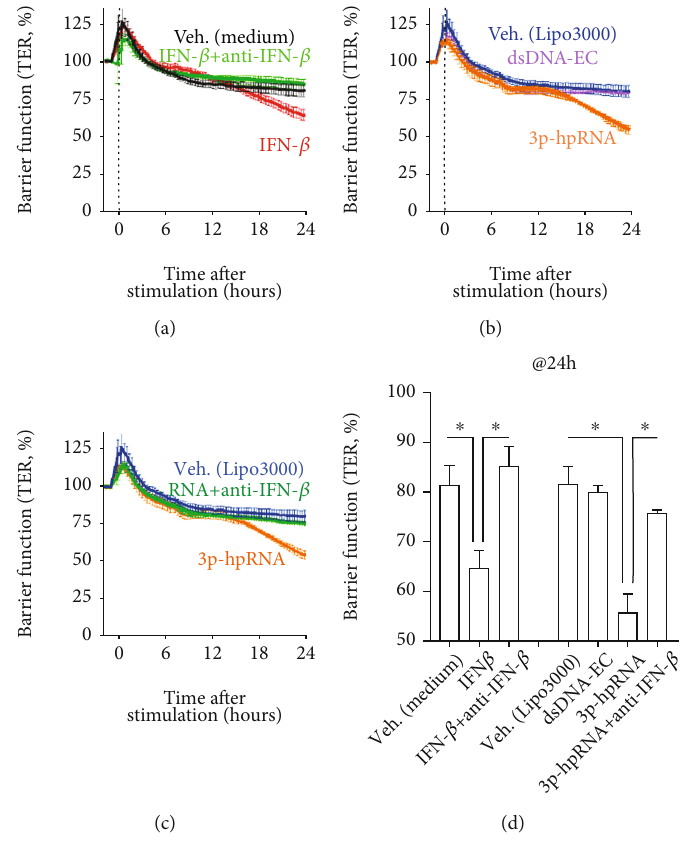
Figure 7: Type I IFN response alters RPE barrier function. iPS-RPE cells were cultured on transmembrane in 24-well plates, and TER was measured as an indicator of RPE barrier function. Note that treatment with IFN- β at 100 ng/mL (a) or transfection with RNA but not DNA at 0.25 μ g/mL (b) could reduce TER, whereas anti-IFN- β could recover the IFN- β -induced (a) and RNA-induced loss of barrier function (c). Normalized TER after 24h treatment is summarized in (d) as a bar graph indicating changes to the barrier function. Each data point represents biological replicates ( n = 3 ). ∗ p < 0 : 05 compared with IFN- β - or 3p-hpRNA-induced group with TER